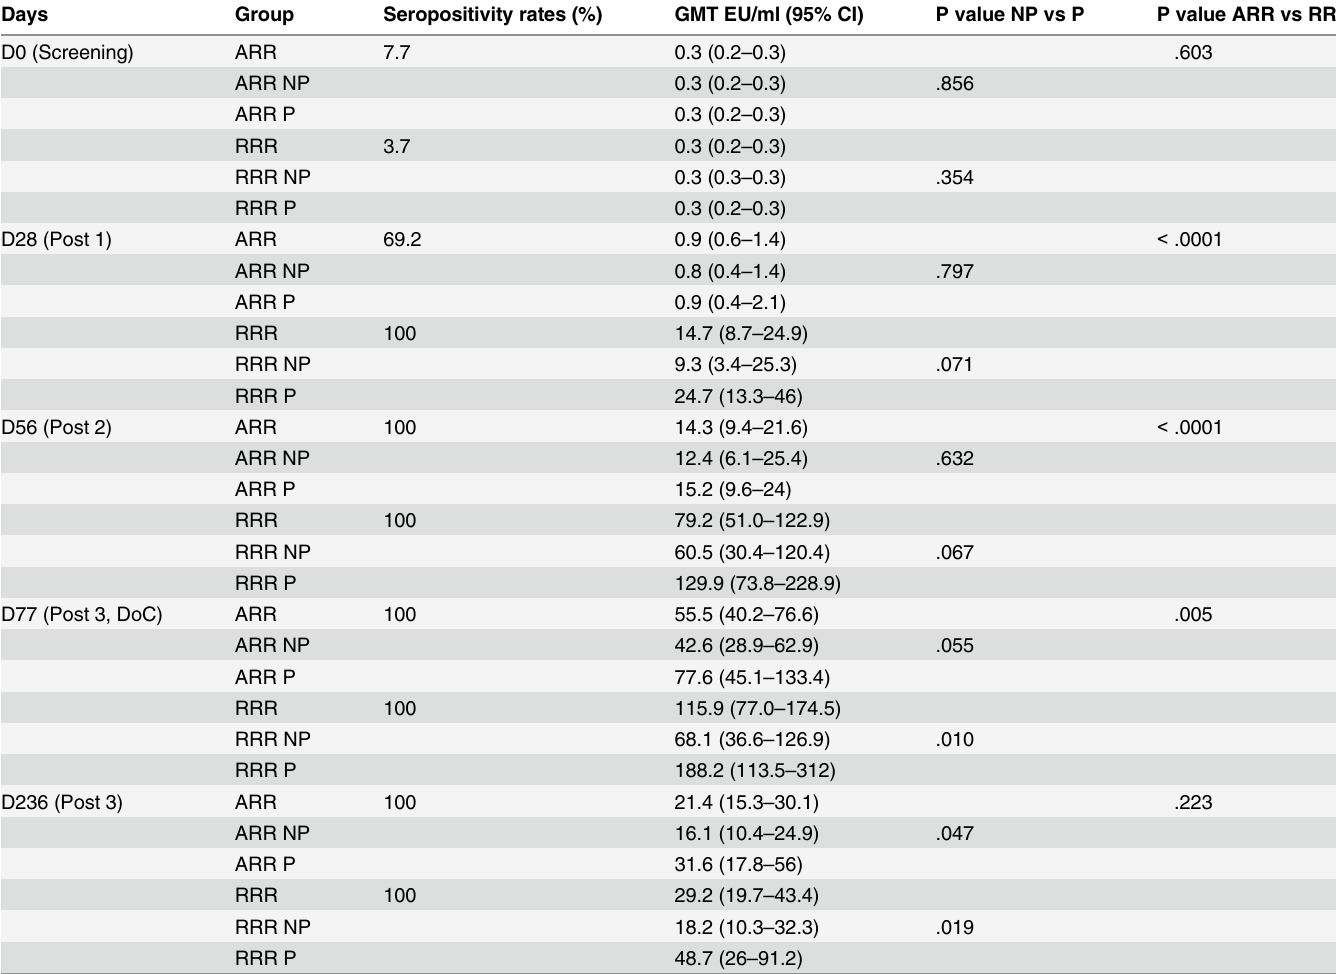
Table 2. Seropositivity rates and Geometric Mean Titer (GMT) for anti-CS antibodies overall and by protection status (ATP cohort for immunogenicity). Days